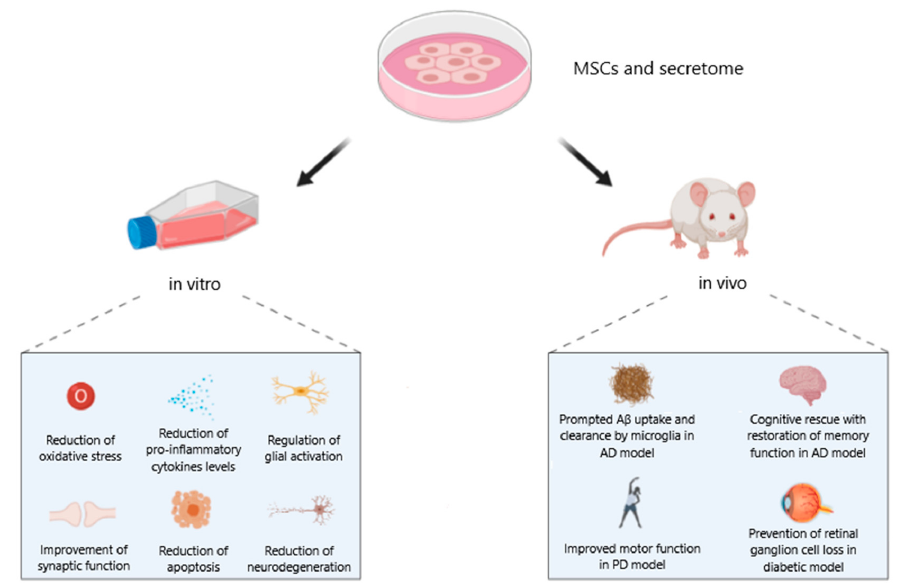
Figure 4. Schematic representation of the redox modulating demonstrated effects of mesenchymal stem cells in counteracting neurodegeneration in vitro and in vivo. Image created with BioRender.com. Table 1. Neurogenic differentiation protocols.